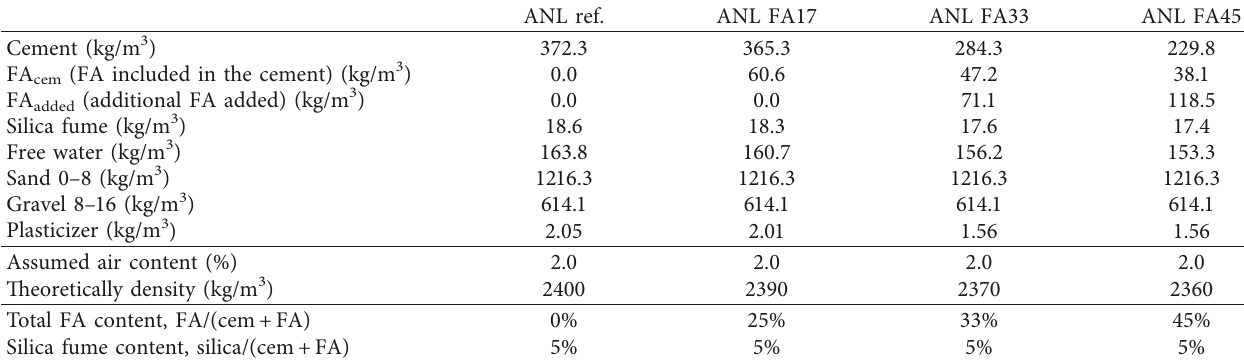
Figure 2: Sketch of the TSTM, after [46]. Table 1: Concrete mix